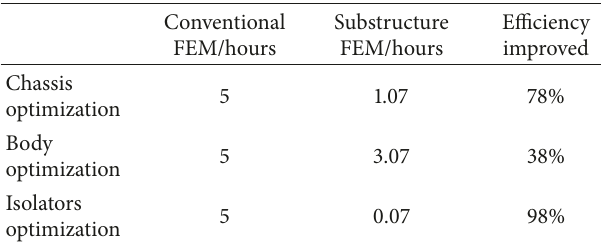
Table 4: Analysis time of